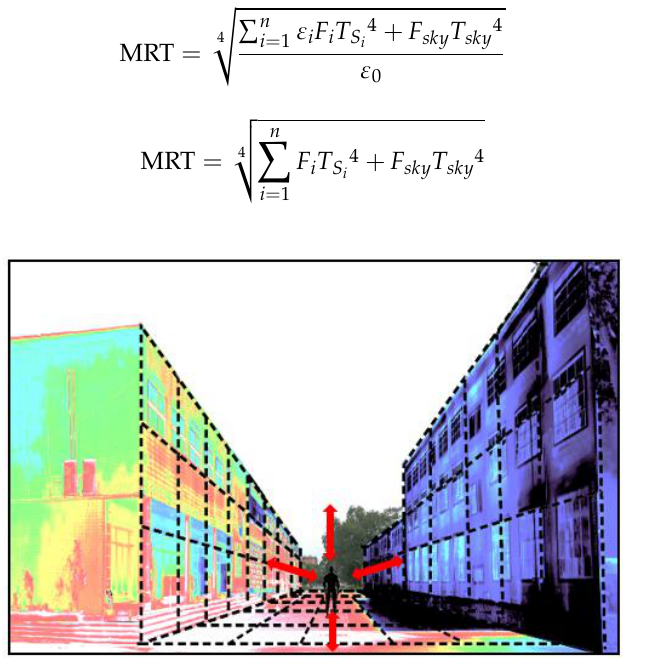
Figure 2. Radiation exchange between the human and surrounding surfaces based on 3D thermography in a pedestrian space.